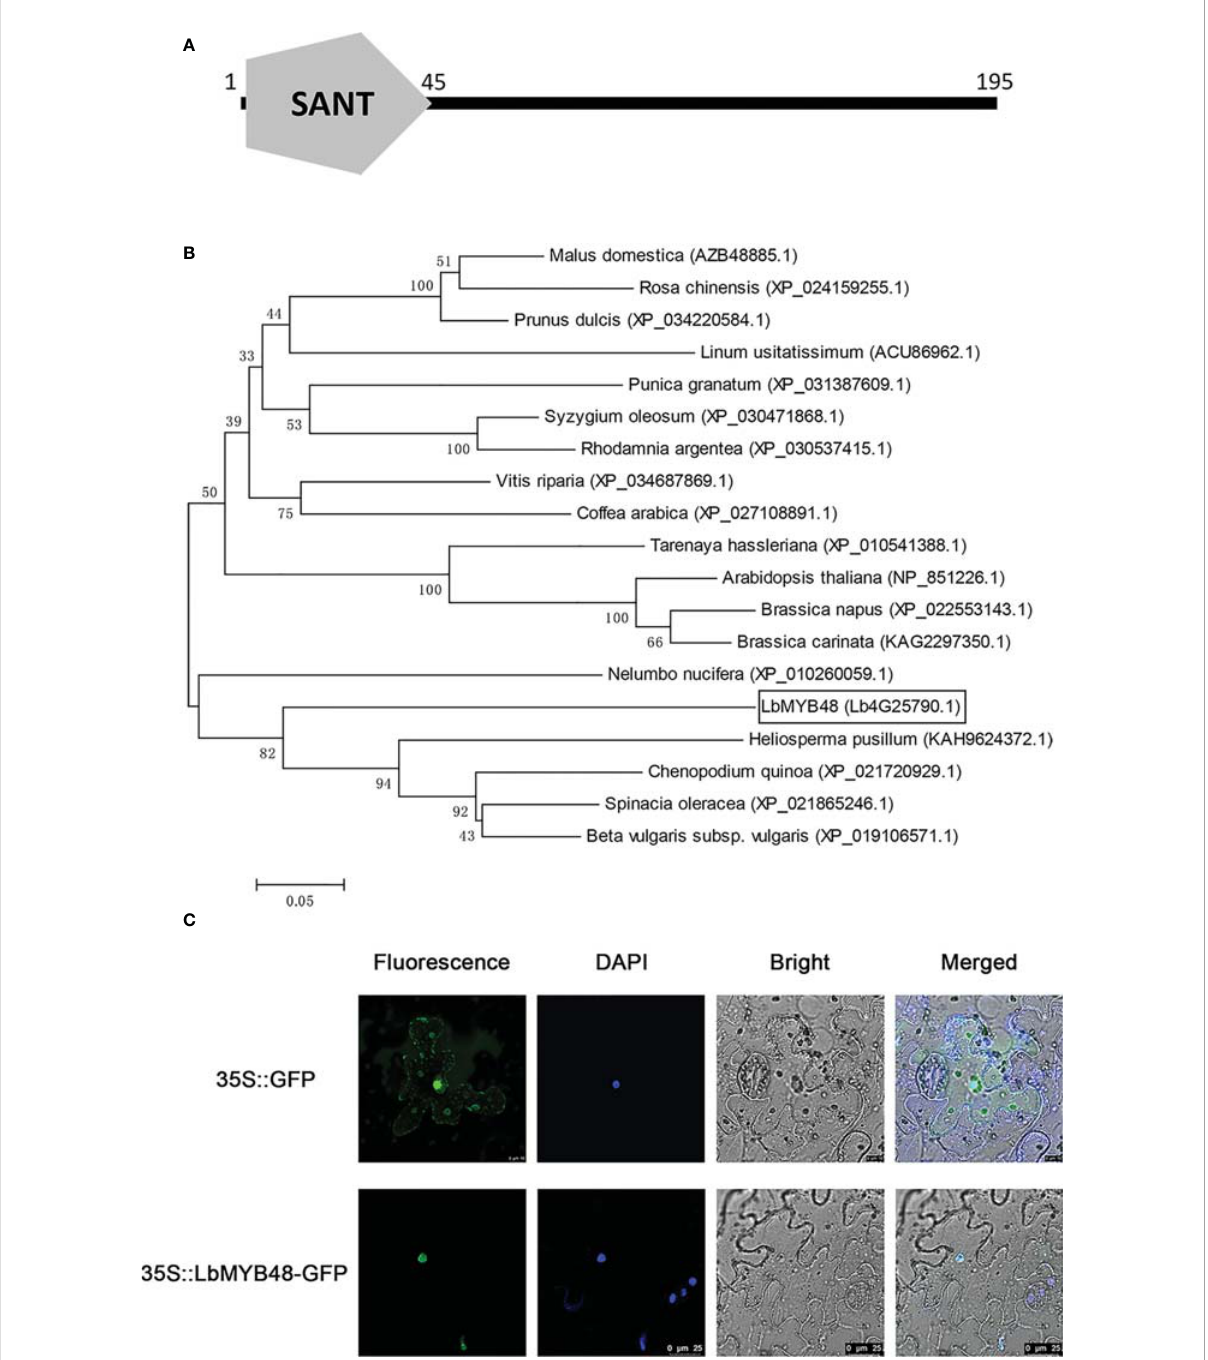
FIGURE 1 LbMYB48 is an R1-type MYB transcription factor located in the nucleus. (A) The conserved domain of LbMYB48 protein; (B) Phylogenetic tree analysis of MYB48 related proteins in different species; (C) The subcellular localization of LbMYB48 in